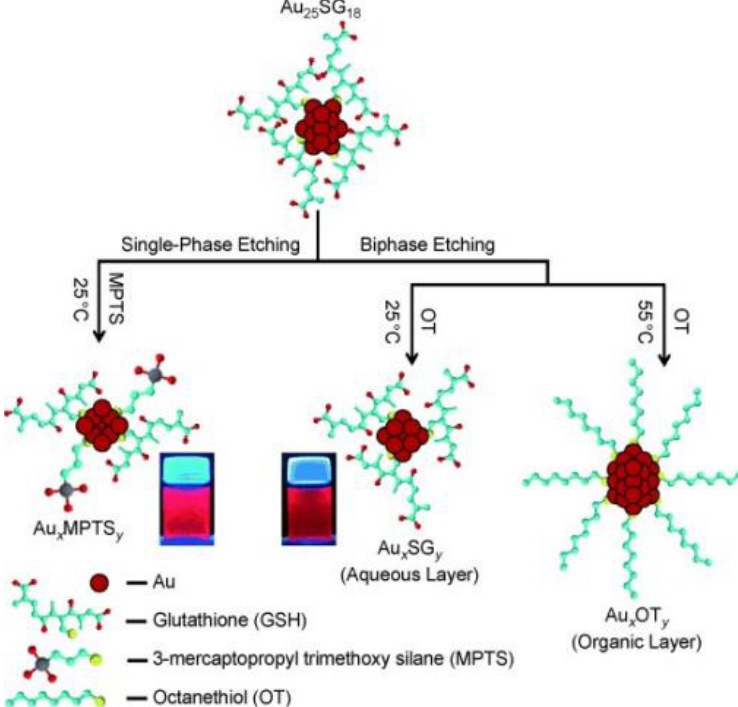
Figure 3. The interface route of thiol etching Au 25 SG 18 . Reprinted with permission from Ref.